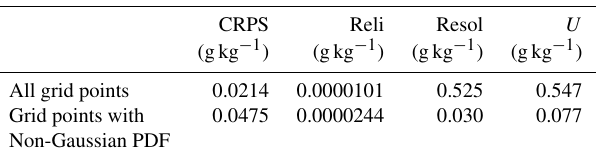
Table 1. CRPS and its three components (reliability, resolution, and uncertainty) for background specific humidity at the lowest